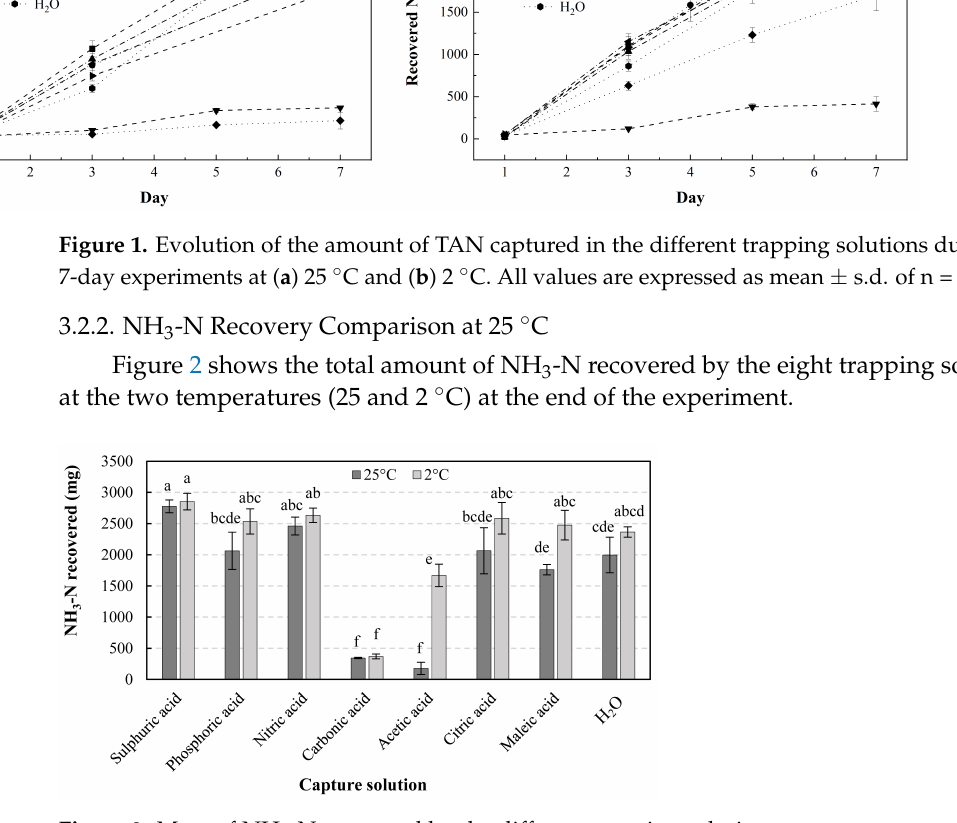
Figure 2. Mass of NH 3 -N recovered by the different trapping solutions at two temperatures after 7 days. Values with different letters are significantly different at p ≤ 0.05 according to Tukey’s HSD test. All values are expressed as means of n =